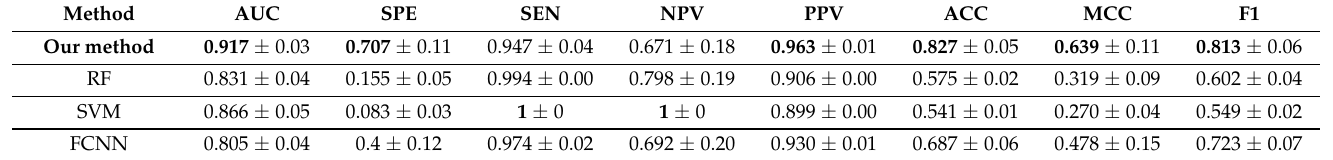
Table 1. 12-fold cross-validation performance comparison with classical machine learning methods such as random forest (RF), support vector machines (SVM) and fully connected neural network (FCNN). For our method while comparing with classical methods, we used images with resolution of 380 × 380 and all 33,153 RNA expression features of autosomal genes. Method Our